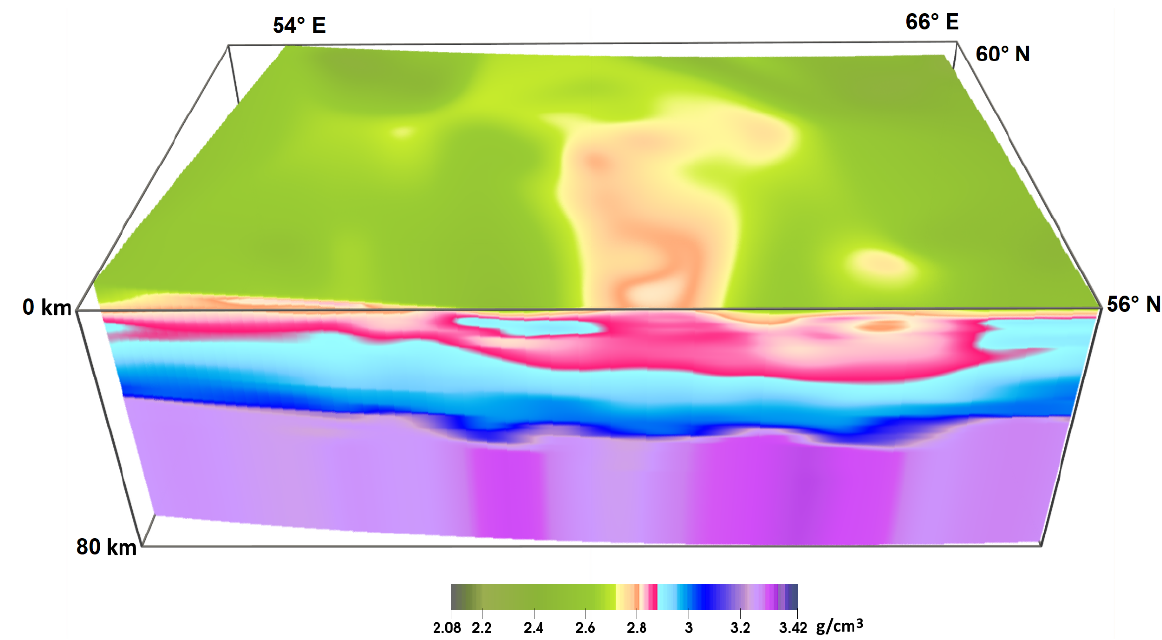
Figure 4. Initial 3D density model (model with the interpolated density). The described interpretation algorithm of the gravity data was applied to the difference δ g ( 0 ) of the observed field and the initial model field (Figure 5).